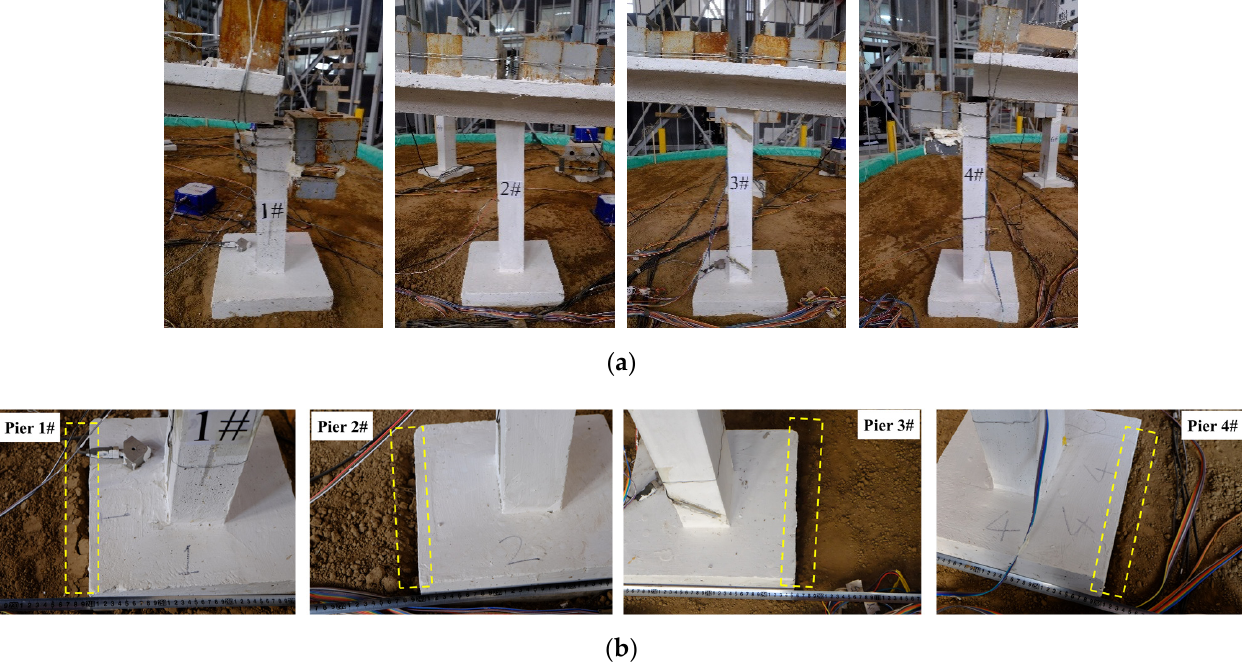
Figure 8. Experimental phenomena: ( a ) before tests; ( b ) after test case No.21.